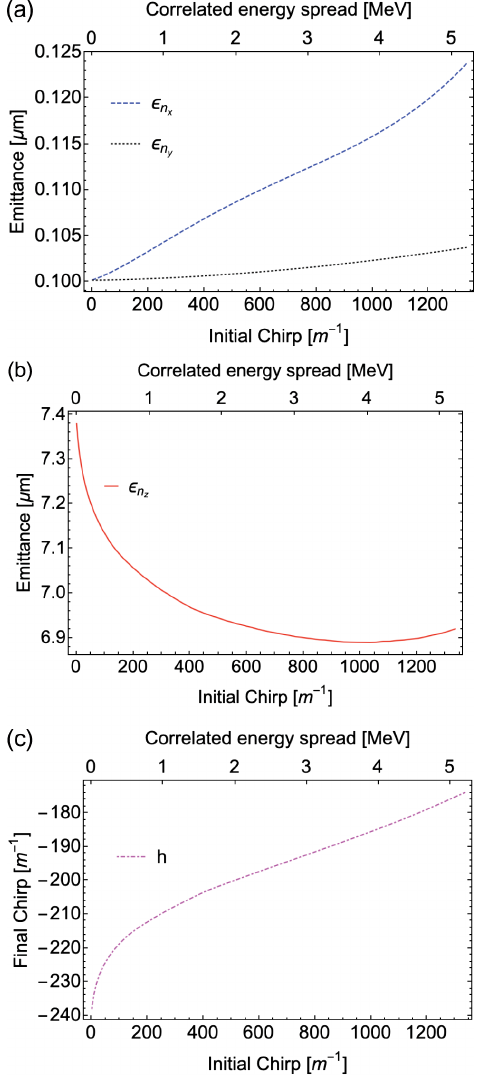
FIG. 16. Transverse (a) and longitudinal (b) emittances and chirp (c) at the exit of the optimized TCBD at 1 GeV versus the initial chirp for a 100 pC